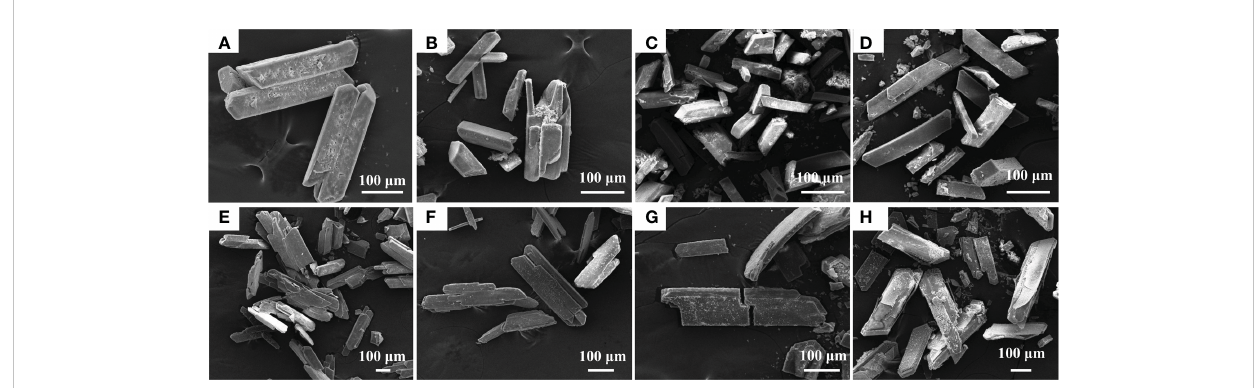
FIGURE 2 Scanning electron microscope (SEM) analysis of mineral crystals induced by Alteromonas at different concentrations of sea salt. Alteromonas spp. were cultured in TSB supplemented with different sea salt concentrations (2%, 4%, 6%, 8%, from left to right) for 5 days. (A – D) , A. alteriprofundi HHU 13199 T ; (E – H) , A. alterisediminis N102 T .